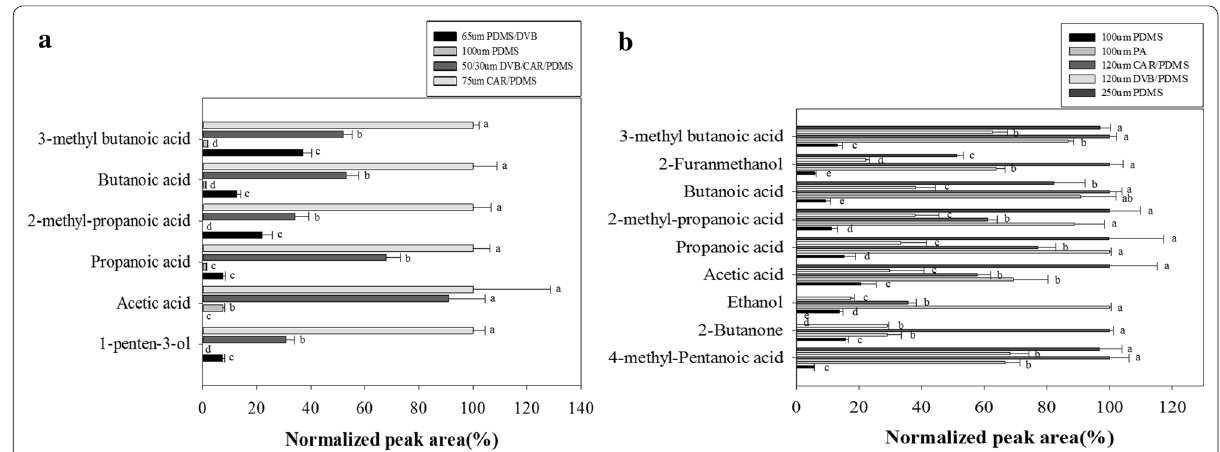
Fig. 1 Comparison of different a SPME and b SPME‑Arrow fibers for the extraction of volatile compounds in sand lance fish sauce ( p <